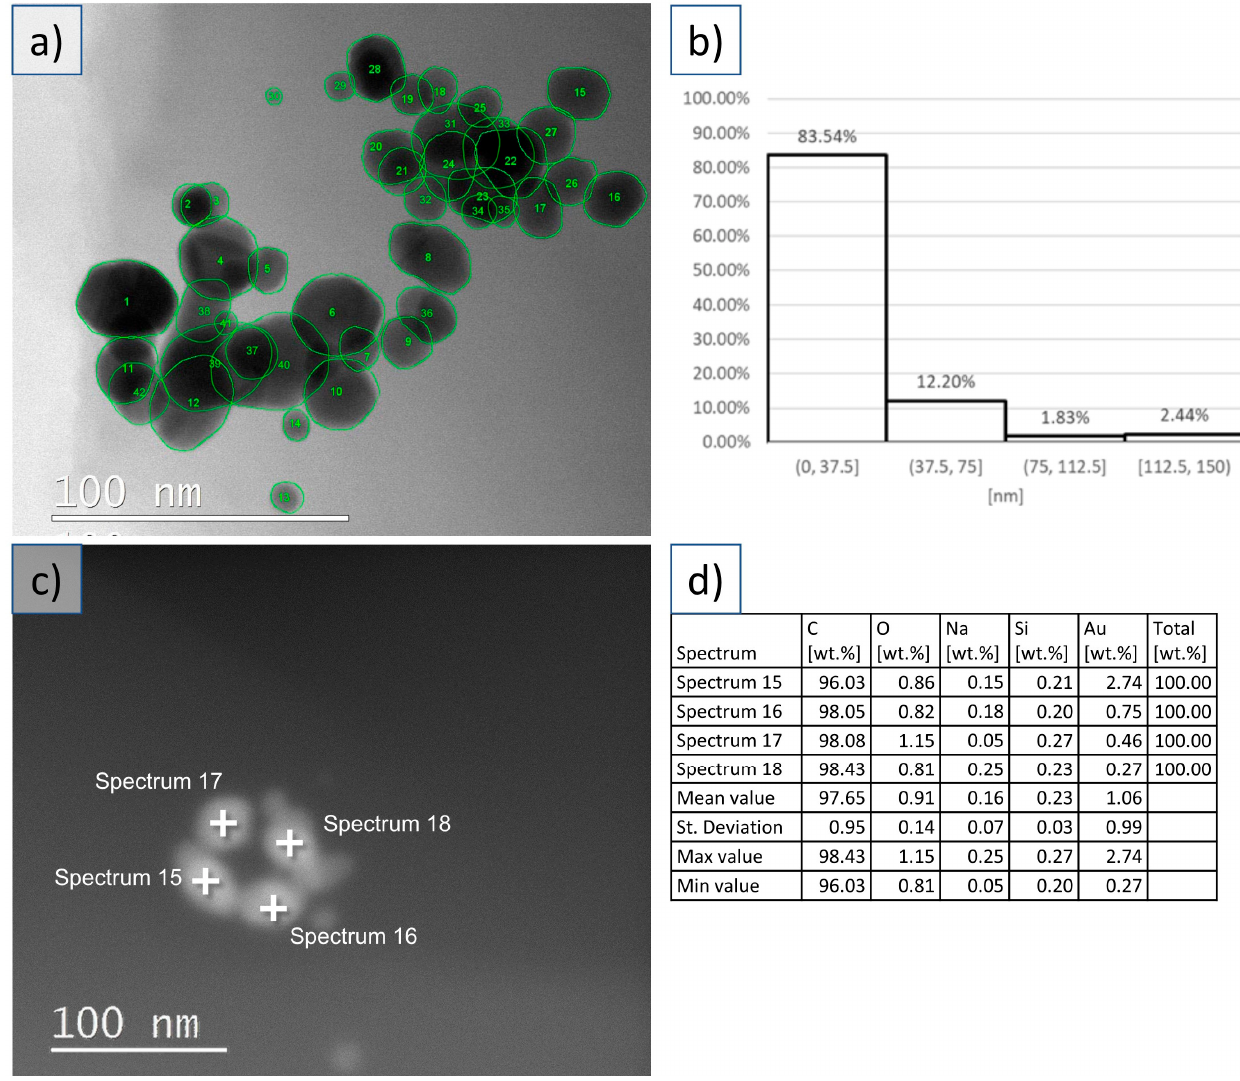
Figure 2. TEM investigations of the dried AuNPs and the cosmetic cream with AuNPs. ( a ) TEM image of the dried AuNPs with particle size and morphology analysis. ( b ) Size distribution of the analyzed AuNPs. ( c ) TEM image of the AuNPs embedded in the cosmetic cream. ( d ) EDX analysis of select points in the corresponding TEM image of the AuNPs embedded in the cosmetic cream. Table 1. Obtained AuNPs’ size and morphology parameters: circularity, aspect ratio, and roundness. Particle diameter (nm) Circularity Aspect ratio Particle Diameter (nm) Circularity Aspect